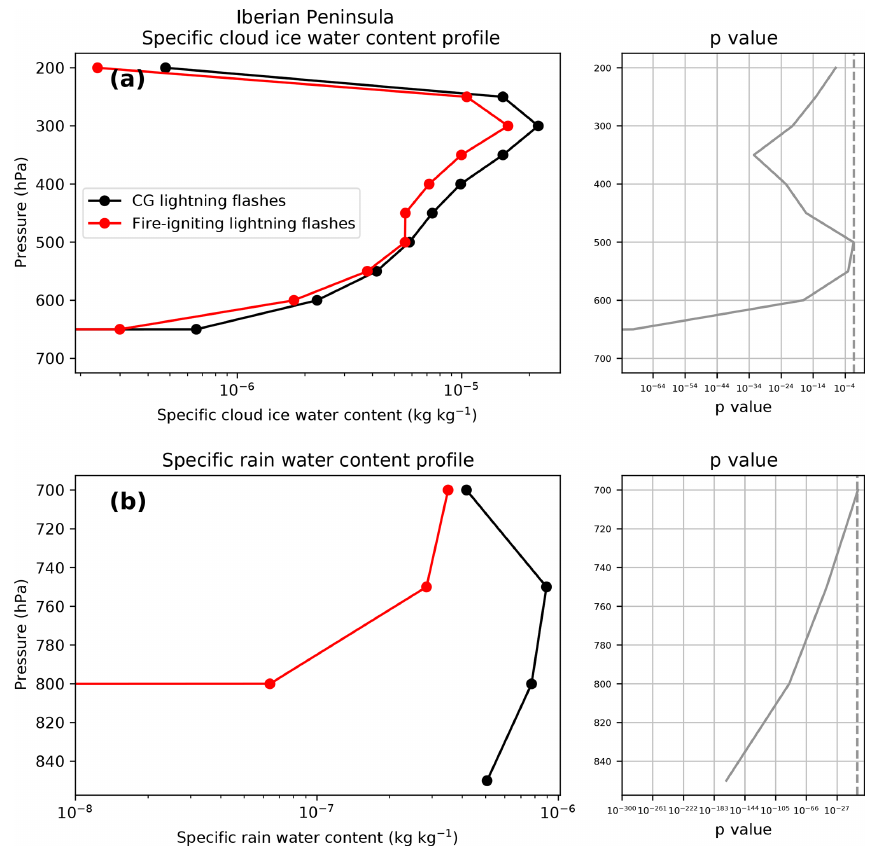
Figure 8. The first column shows the vertical profiles of the specific cloud ice water content (a) and the specific rain water content (b) for the CG lightning and the fire-igniting lightning climatologies during May and September in the Iberian Peninsula between 2009 and 2015. The second column shows the p value (solid line) for each vertical level, representing the probability of equal median between both distributions, and a mark showing the limit at 0.05 (dashed